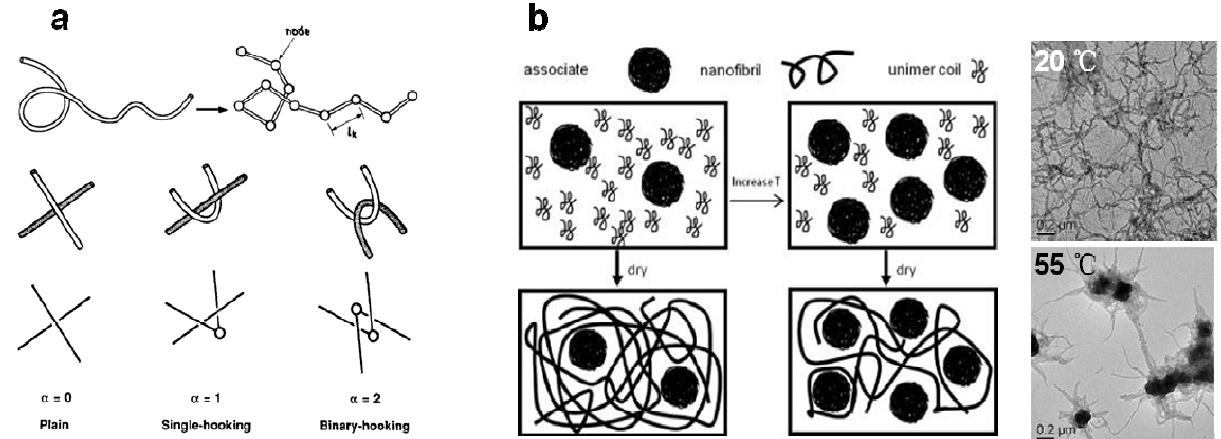
Figure 16. ( a ) The entanglement model reported by Wu: top are the schematic illustration of a real chain and its equivalent Kuhn chain and down are the types of inter-chain contacts associated with entanglement, (Adapted with permission from [134]. Copyright 1989 Wiley-VCH Verlag); and ( b ) The schematic illustration of equilibrium between unimer coils and associates in solution on the final film morphology and the corresponding TEM image of films. (Adapted with permission from [136]. Copyright 2010 American Chemical